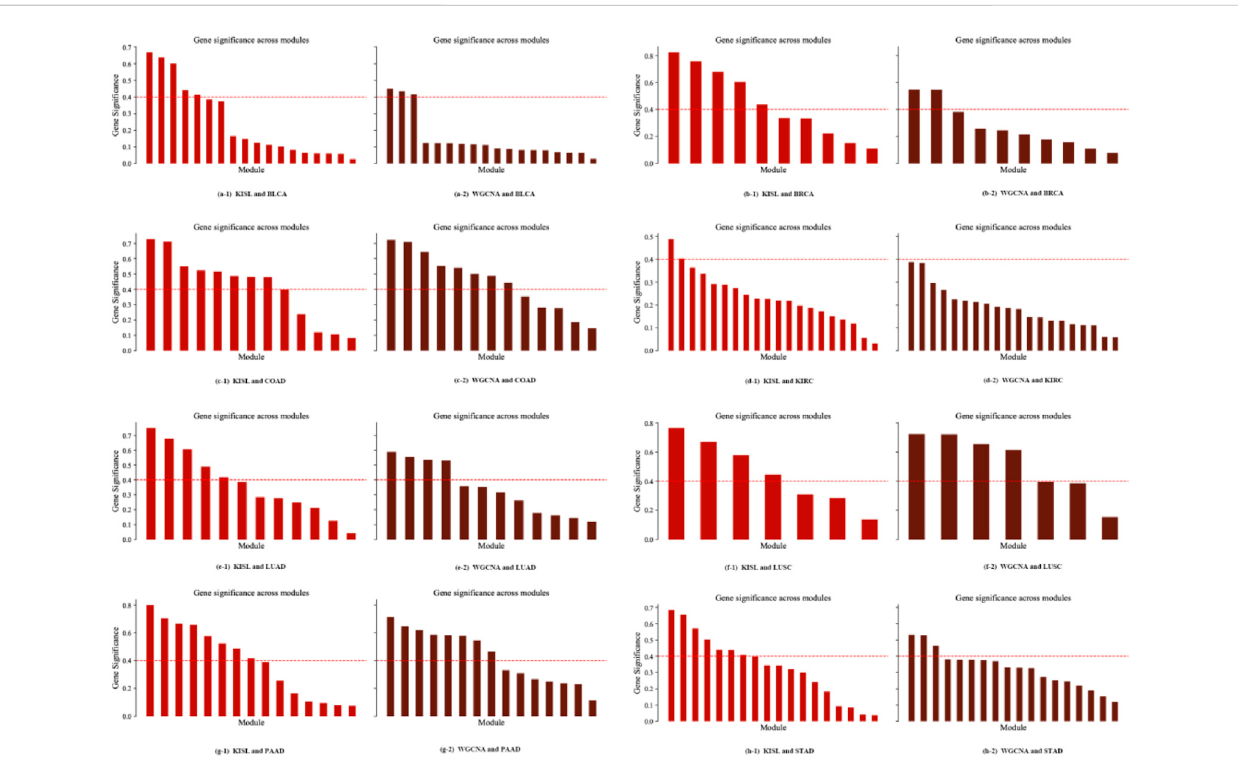
FIGURE 7 Module signi fi cance metric. The gene module signi fi cance threshold is set to 0.4 (the red dashed line), and our algorithm obtains more high gene signi fi cance modules on fi ve of the datasets, BLCA, BRCA, KIRC, LUAD and STAD (Figures 7A,B,D,E,H), while on the other three datasets our method obtains the same number of high signi fi cance modules as the base